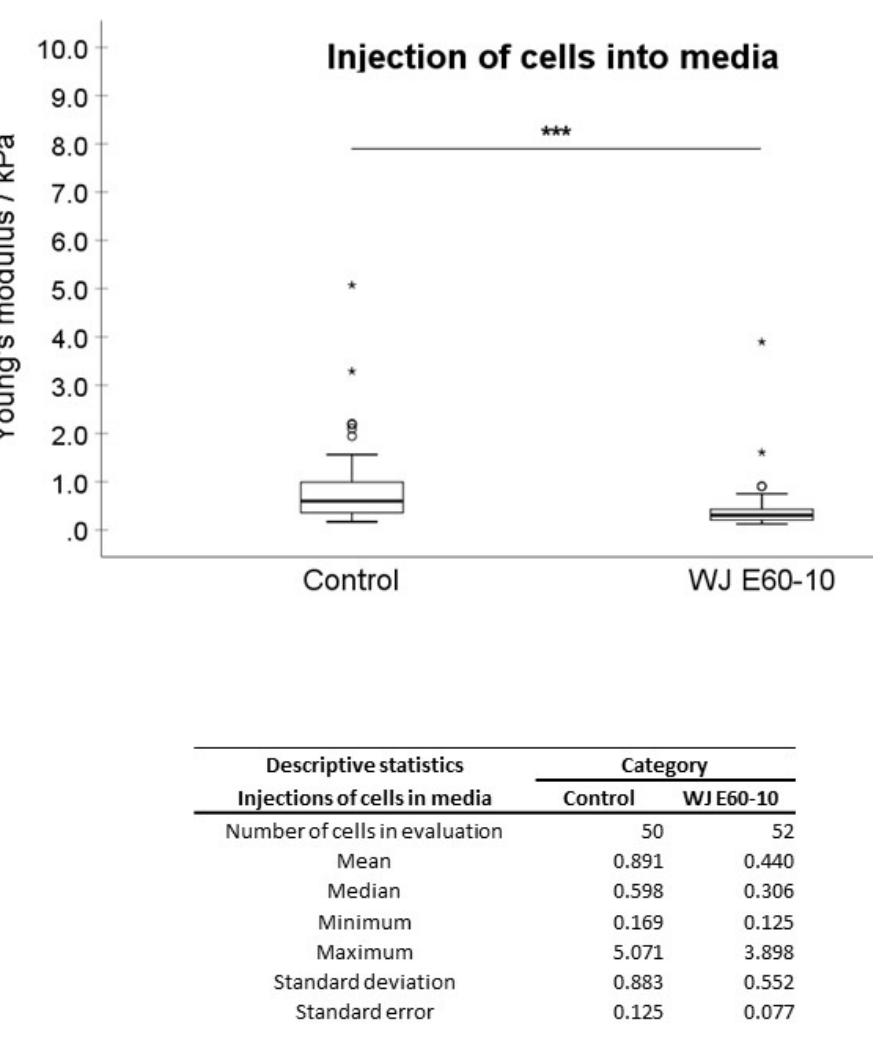
Figure 3. Analysis of Young’s modulus of cell injections by WJ capture fluid. Boxplots (medians, minimum, maximum) of the stiffness (kPa) measured by atomic force microscopy for controls and WJ-injected pADSCs in capture fluid are depicted. The control (untreated) cell monolayers revealed a higher stiffness when compared to the WJ group. Descriptive statistics of Young’s moduli in control and WJ-injected cells in capture fluid. Medians with minimum and maximum, means, standard deviations and standard errors of mean of both groups are depicted. *** p < 0.001. Abbreviations: WJ—waterjet.